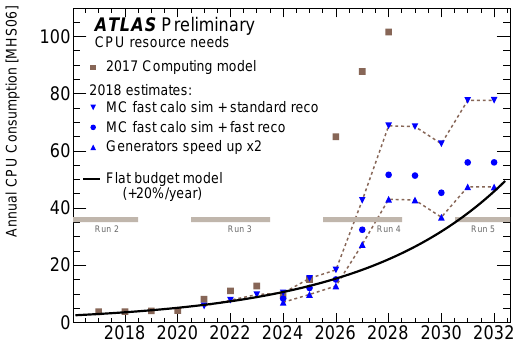
Figure 1. The estimated CPU resources needed by the ATLAS experiment for data and simulation processing. The brown points are estimates made in 2017, based on existing software performance estimates and using the ATLAS computing model parameters from 2017. The blue points show the improvements possible in three di ff erent scenarios: (1) top curve with the fast calorimeter simulation used for 75% of the Monte Carlo simulation; (2) middle curve using in addition a faster version of reconstruction, which is seeded by the event generator information for the tracks; (3) bottom curve, where the time spent in event generation is halved, either by software improvements or by re-using some of the events. The solid line shows the amount of resources expected to be available if a flat funding scenario is assumed, which implies an increase of 20% per year, based on the current technology trends. From Ref.